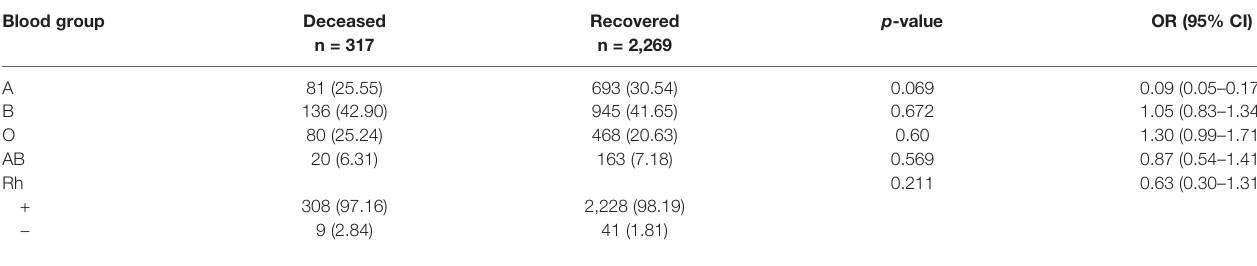
TABLE 4 | Distribution of ABO and Rh blood groups between deceased and recovered COVID-19-infected patients. Blood group